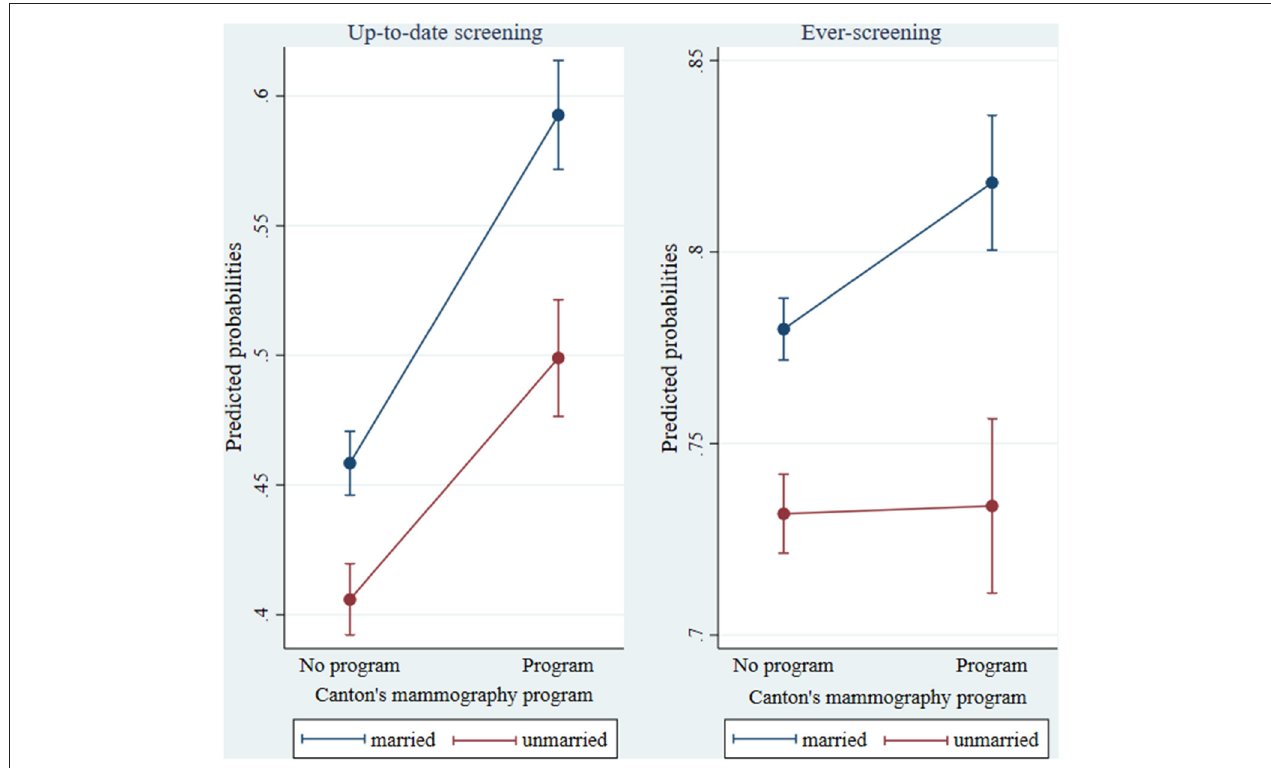
FIGURE 2 | Predicted probabilities of mammography up-to-date and ever-screening by marital status in cantons with/without a mammography program (based on model 2b). Confidence intervals were calculated using a multiplier of 1.39 standard errors since two parameters are compared rather than a parameter and a single (fixed) point (Goldstein H, Healy MJR. The graphical presentation of a collection of means. J R Statist Soc . (1995)